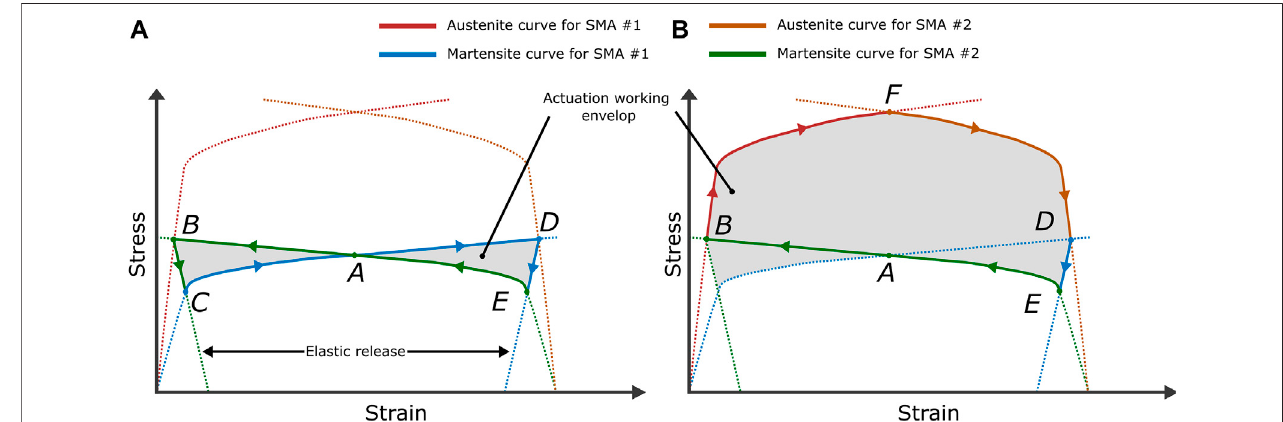
FIGURE 11 | Example of active biased SMA performance tests: (A) : motion range tests, the (B – D) presents the maximum of motion range. (B) : maximum output stress tests, the F presents the maximum output stress of system at certain temperature. The Panel is inspired by Georges et al. (2012).